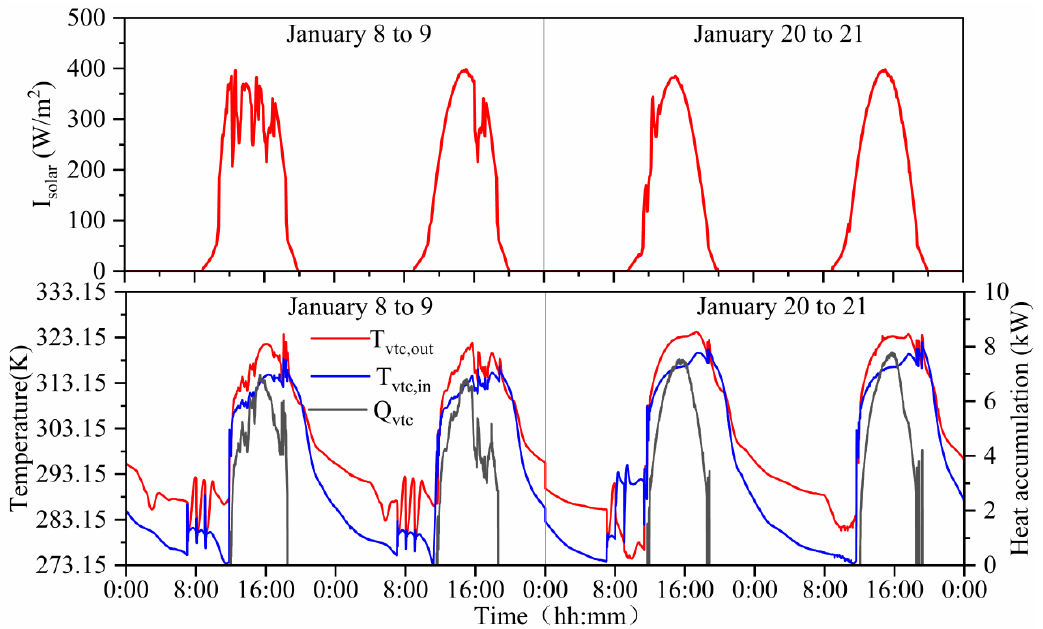
Figure 3. I solar , T vtc,out , T vtc,in , and Q vtc vs. operation time. Mode 1: The experimental test data for Mode 1 are presented in Figure 4a. On